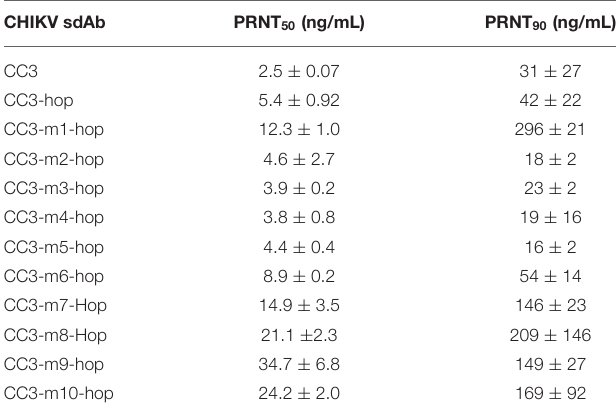
TABLE 2 | Neutralization of CHIKV strain 181/25 by CC3, CC3-hop, and